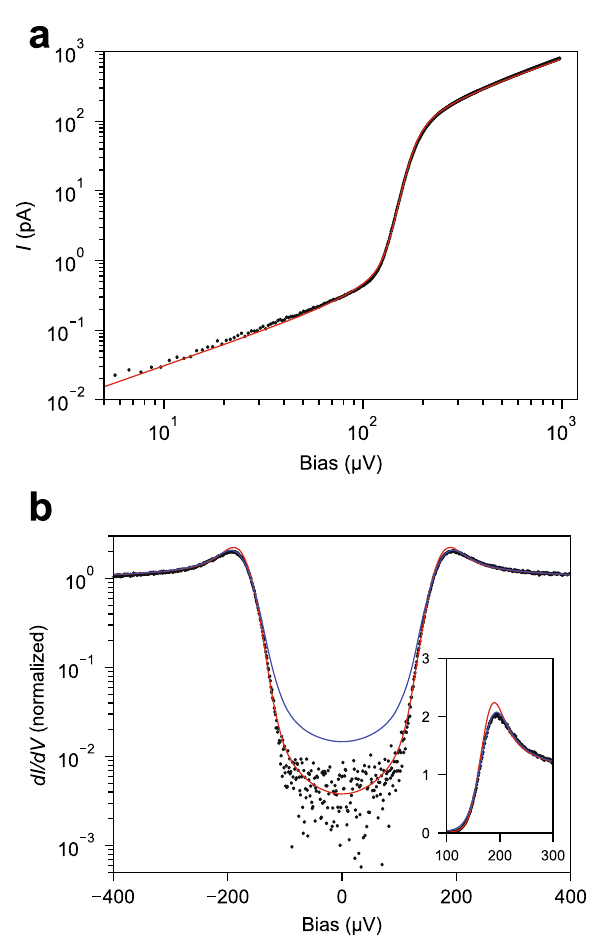
Fig. 8 Fitting the experimental I ( V ) spectrum of the superconducting gap with the modi fi ed routine. a Fit of the I ( V ) curve from Fig. 6b, achieved with the modi fi ed fi tting routine (cf. text). b Differential conductance d I /d V spectrum corresponding to the I ( V ) curve of a , plotted on a logarithmic scale to expose the quality of the fi t in the low conductance regime. The red curve is generated with the same parameter set as in a . The blue curve is the fi t from Fig. 6a. Quasiparticle peak feature plotted on a linear scale